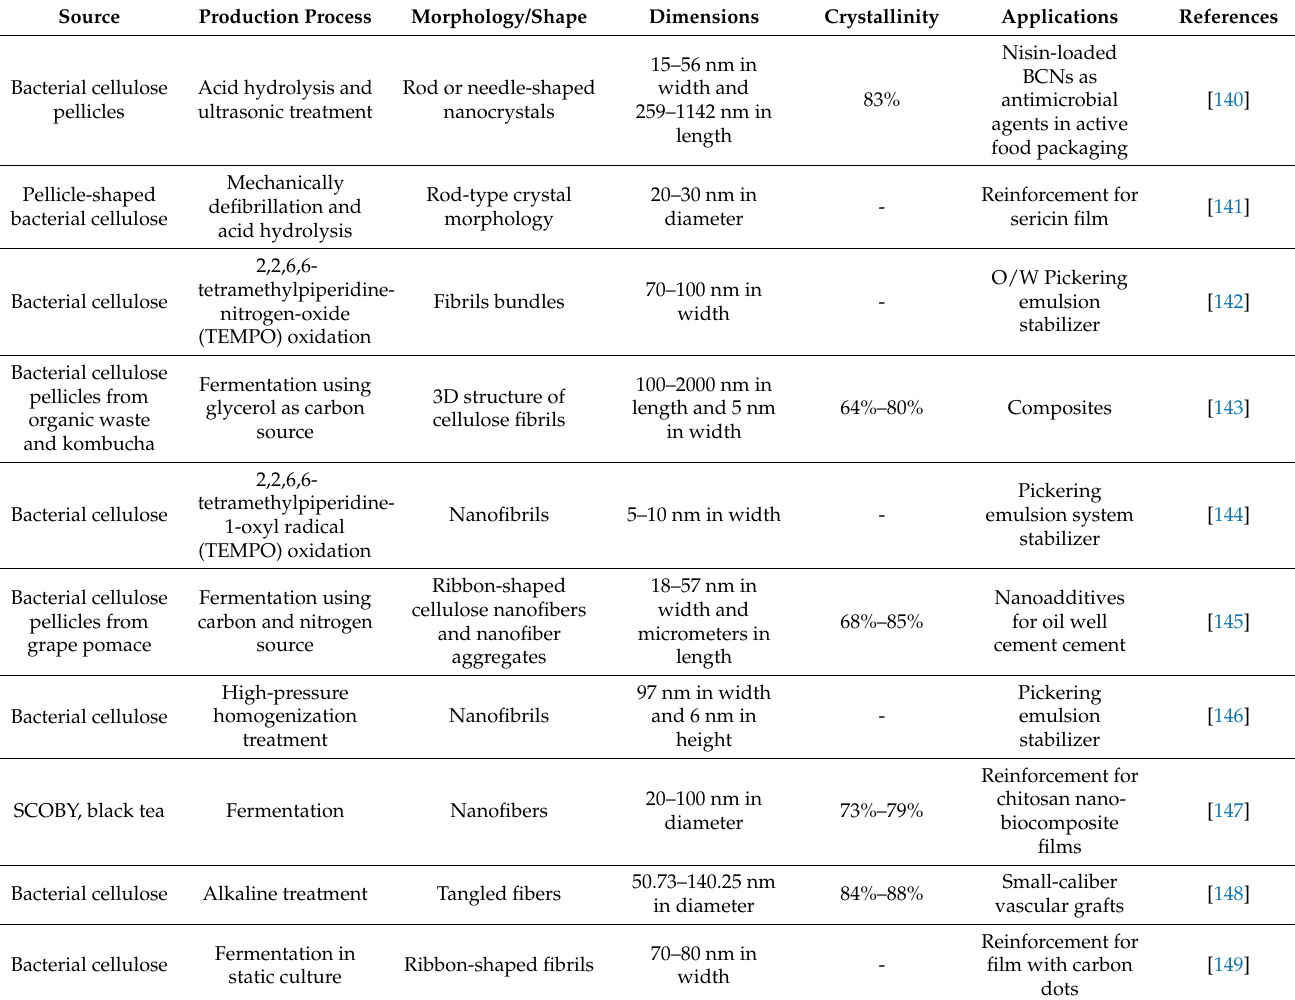
Table 5. Recent advances in the production process, physicochemical characteristics and application of CNF extracted from different bacterial sources and substrates (literature data for years 2020 and